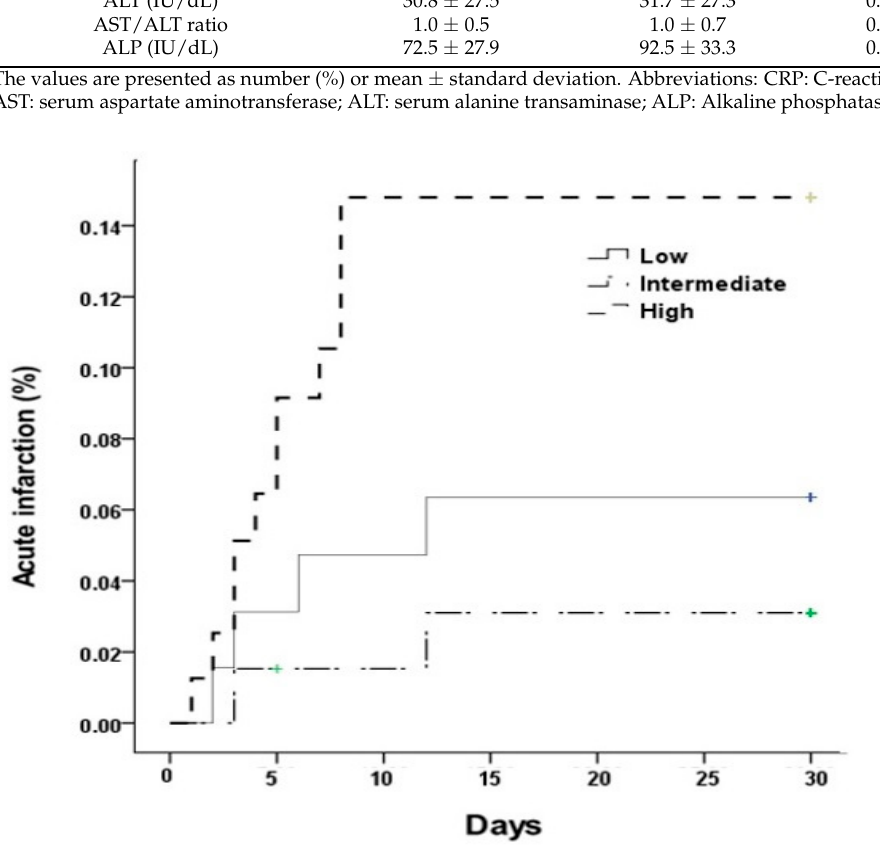
Table 4. Logistic regression analysis of the relationship between ALP and adverse neurologic event or acute infarction.